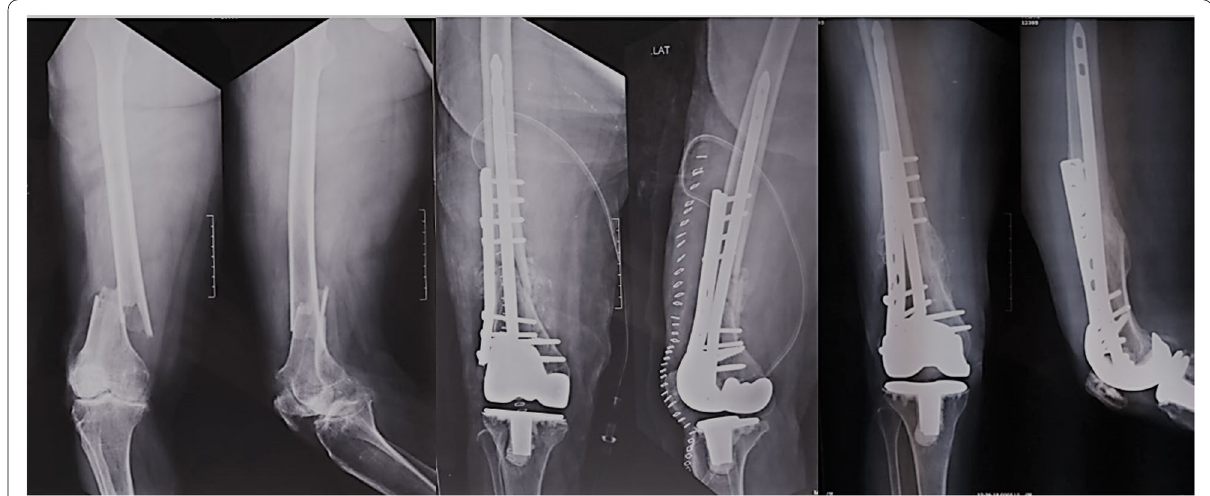
Fig. 4 a Preoperative distal femural fracture with RA knee. b Postoperative fracture fixation with TKA, nNail and locking plate. c Healed fracture with implants in